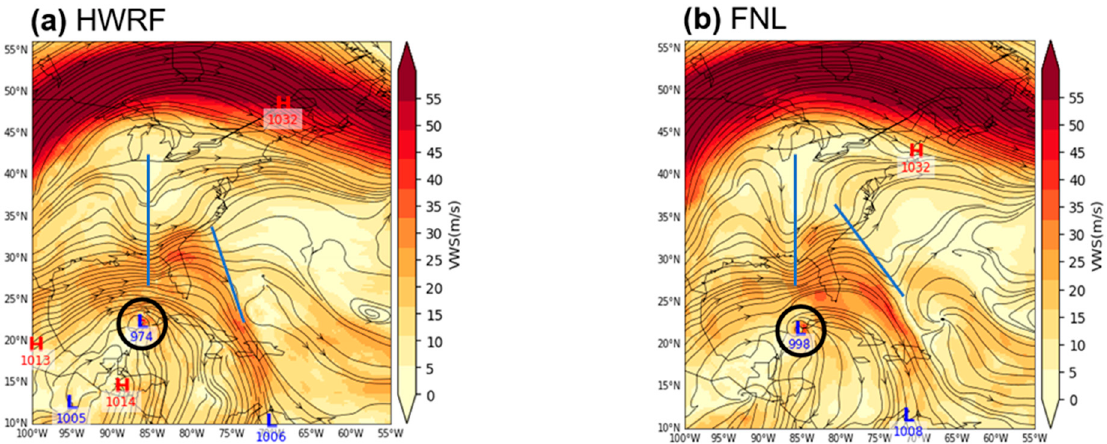
Figure 7. Deep-layer (200–850 hPa) vertical wind shear (VWS, shaded), 200 hPa streamlines, and mean sea level pressure (MSLP) centers in the environment near Hurricane Michael from ( a ) 48 h into an HWRF forecast initialized at 1800 UTC on 06 October 2018 and ( b ) FNL valid at 1800 UTC on 08 October 2018. The center position of Michael is identified by a black circle. VWS has units of m s − 1 , and MSLP has units of hPa. The trough axes relevant to these discussions are marked by blue lines.